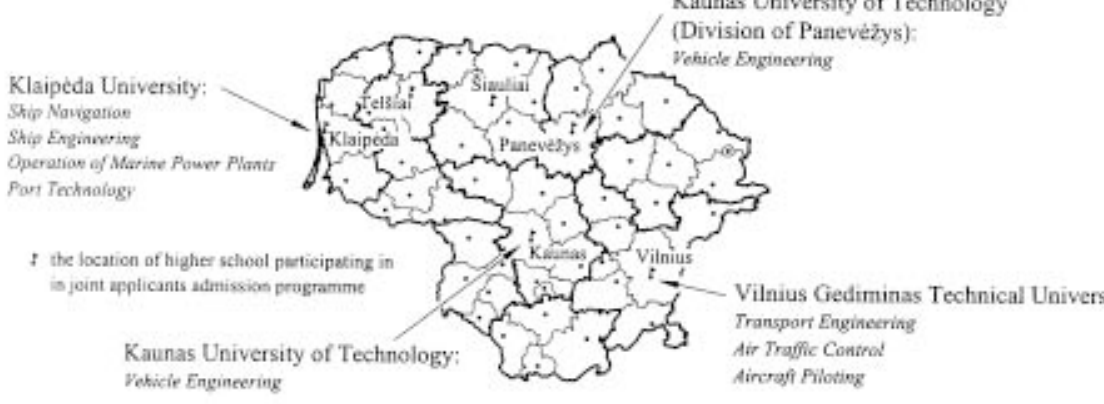
Fig 1. A map of Lithuania showing the location of universities providing courses of studies in transport